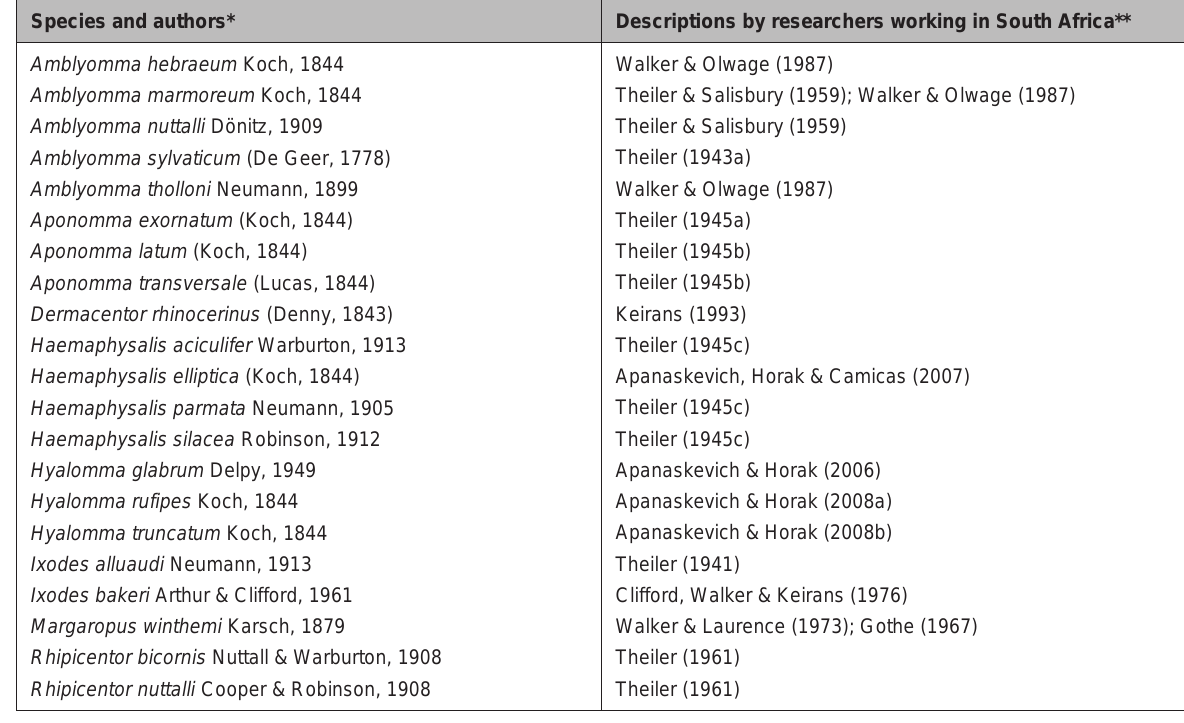
TABLE 3 South African ticks, other than Rhipicephalus species, described by foreign researchers, for which additional descriptions have been produced by researchers in South Africa since 1908 Species and authors*